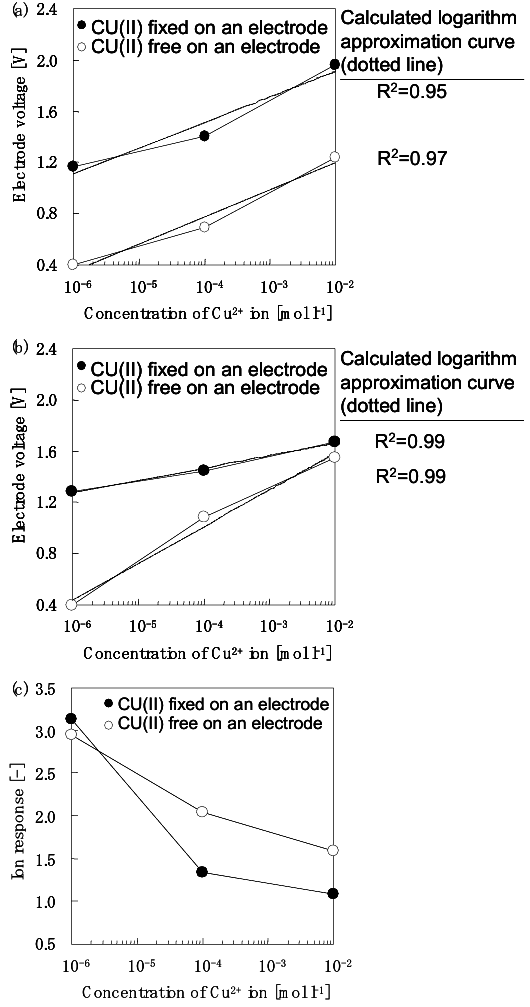
CU(II) fixed on an electrode CU(II) free on an